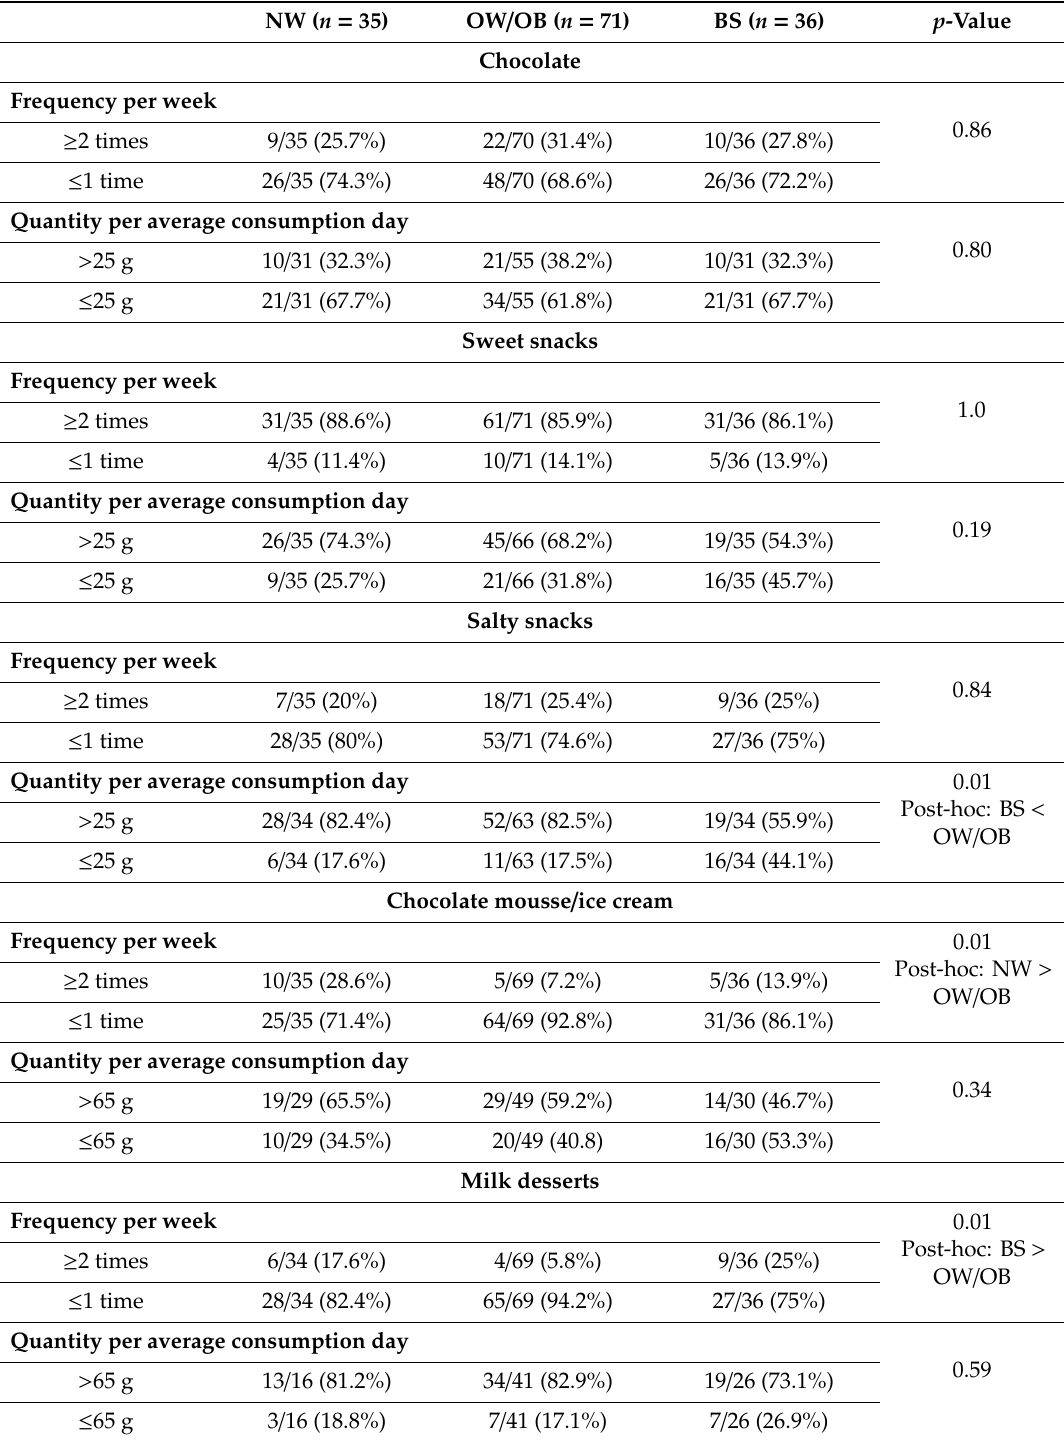
Table 6. Snack consumption by the